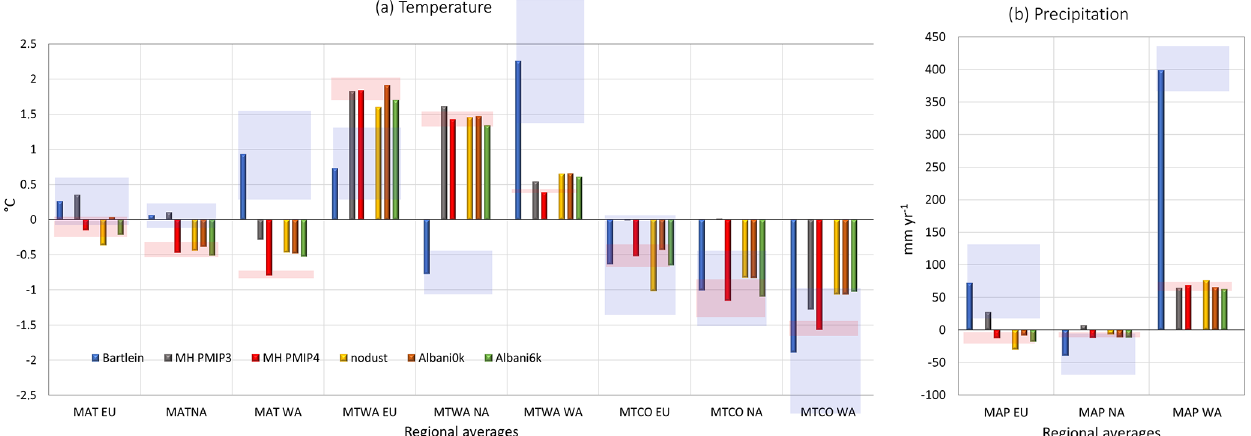
Figure 6. Comparison of the mid-Holocene simulated changes with Bartlein et al. (2011) temperature and precipitation reconstructions over Europe (EU), North America (NA) and West Africa (WA). The different indicators in (a) are the mean annual temperature (MAT, ◦ C), the temperature of the warmest month (MTWA) and the temperature of the coldest month (MTCO, ◦ C), and in (b) the mean annual precipitation (MAP, mmyr − 1 ). The blue intervals stand for the reconstruction uncertainties, estimated from the standard deviation provided by Bartlein et al. (2011) for each grid point. The red intervals stand for the mean root mean square difference between non-overlapping 150 year averages computed from the MHREF simulation and used here as an estimate of model mean annual cycle